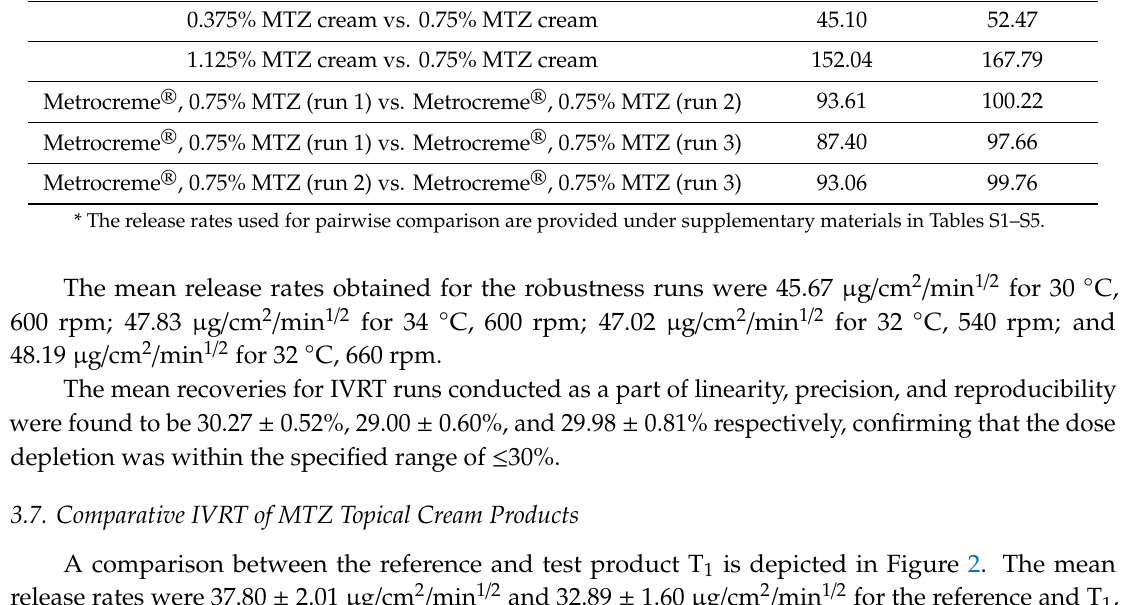
Table 5. Computed 90% CI to assess the selectivity of the IVRT method. Pairwise Comparison